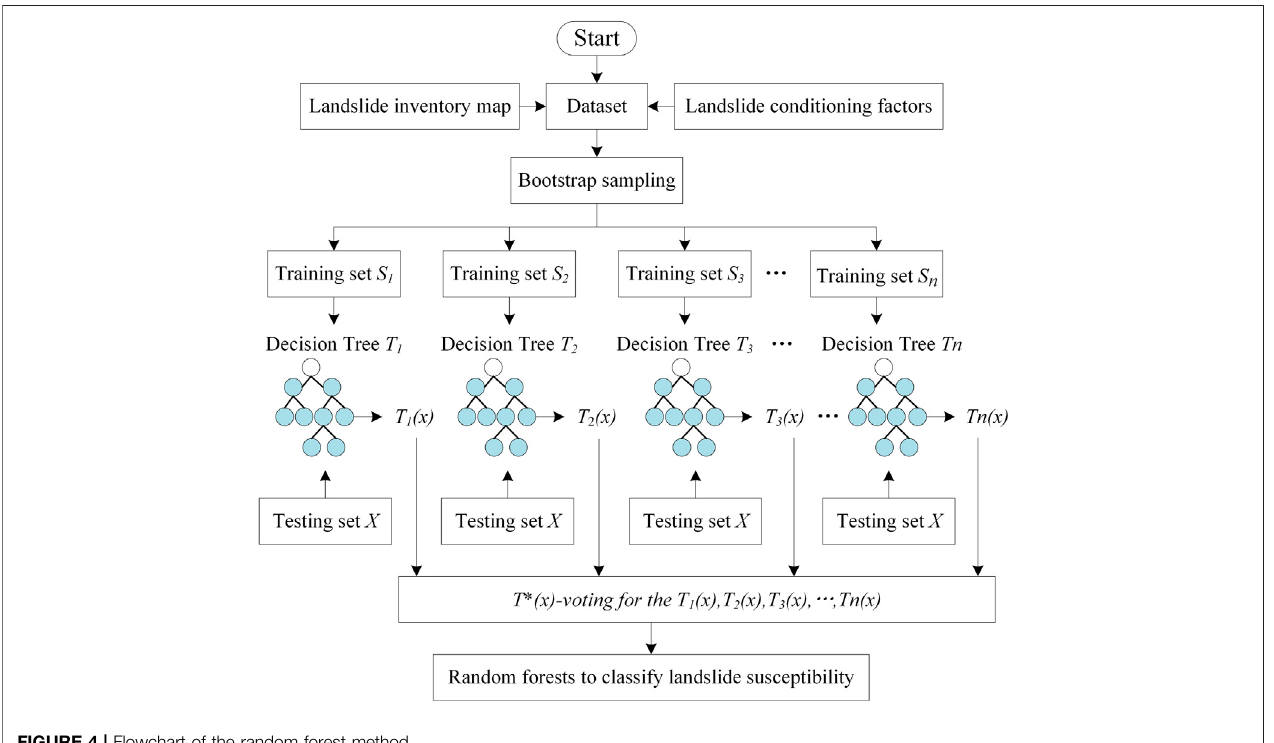
FIGURE 4 | Flowchart of the random forest method.